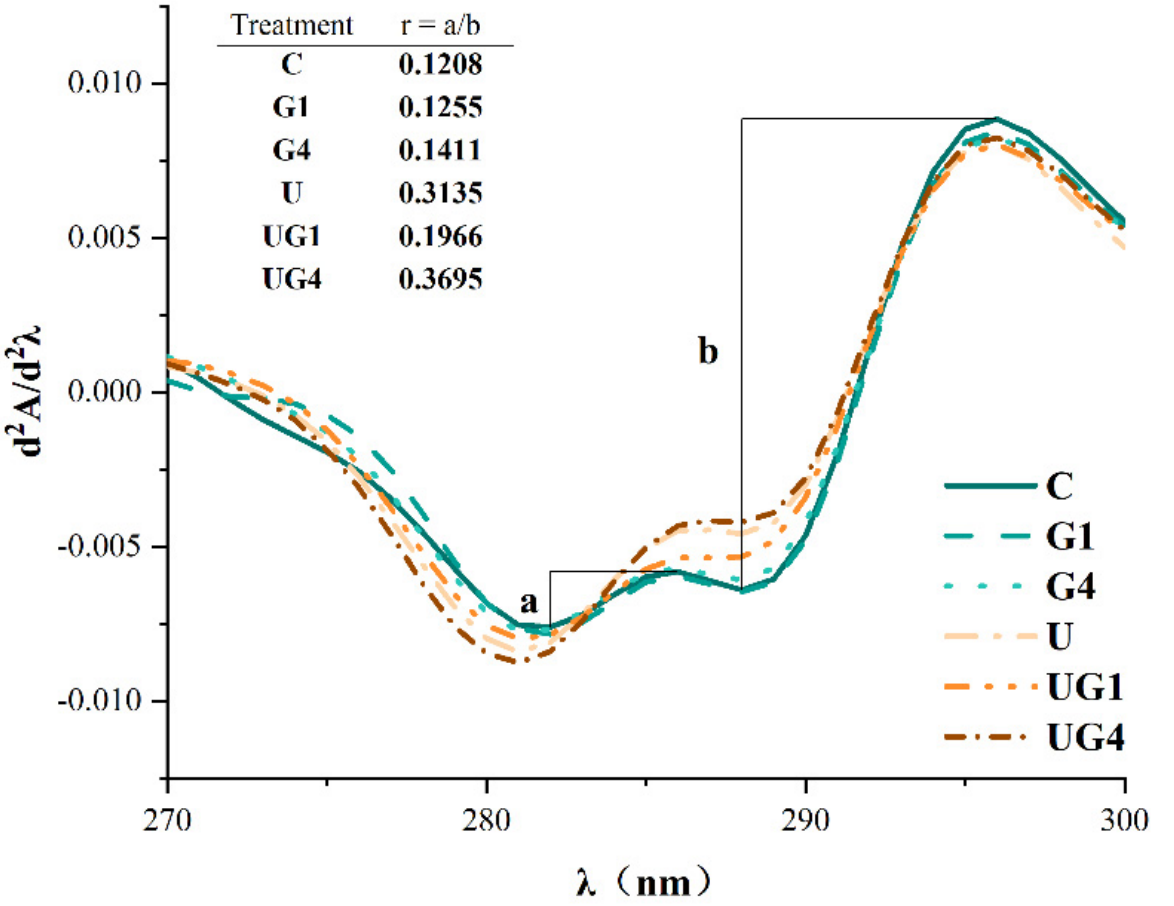
Figure 4. The second derivative of the UV spectra under different treatment conditions. C: 3% NaCl; G1: 3% NaCl and 1% glycerol; G4: 3% NaCl and 4% glycerol; U: 3% NaCl with UT; UG1: 3% NaCl and 1% glycerol with UT. UG4: 3% NaCl and 4% glycerol with UT.